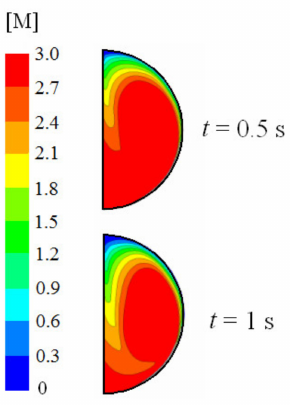
Figure 5. Concentration of NH 3 for time (t) 0.5 and 1 s. 5% initial ammonia concentration, 100 ◦ C initial gas temperature, 5 ◦ C initial liquid temperature, and 1000 µ m initial droplet